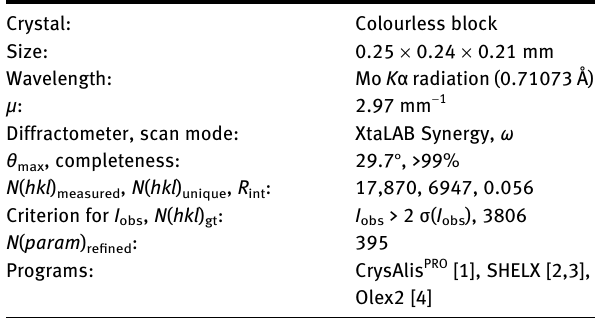
Table  : Data collection and